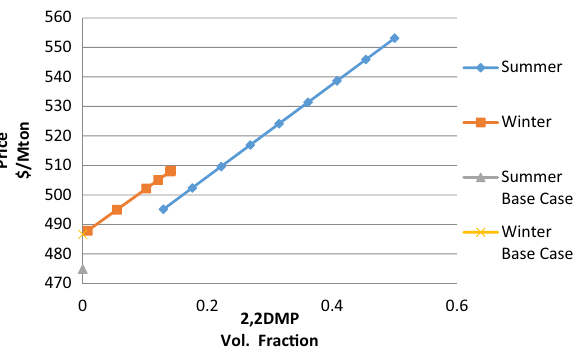
Fig. 11 Effect of adding i-C5 on LPG price